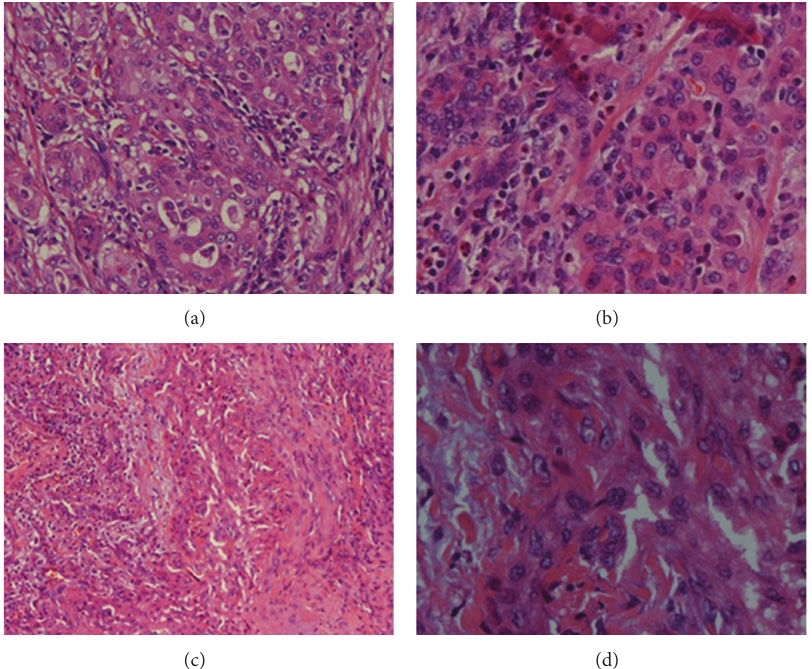
Figure 1: (a, b, d) Poorly differentiated ATC, eosinophilic cytoplasm of neoplastic cells, irregular nuclei with coarse chromatin, and prominent nucleoli; (c) recurrent ATC involving upper lobe of the